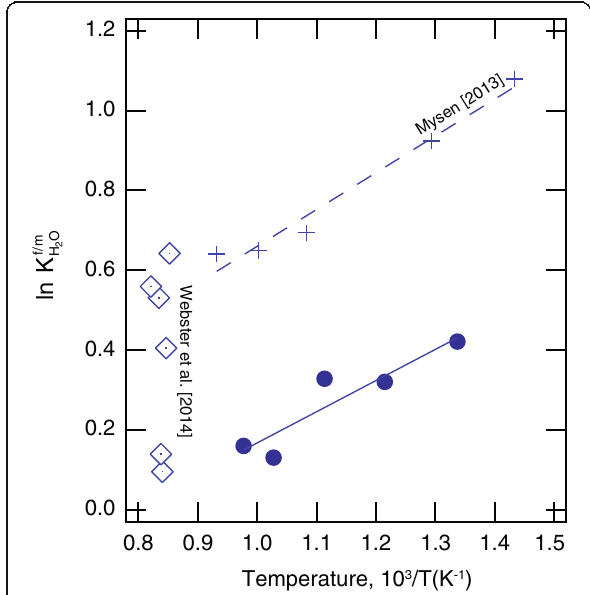
Fig. 13 Partition coefficient between fluid and melt of total H 2 O, K H2Of/m , as a function of temperature. The least squares straight line fit is, K H2Of/m = − 0.6±0.2+782±189/T, r 2 =0.85. Also shown are data from natural samples by Webster et al. (2014) and from experimental data in silicate – H 2 O from Mysen (2014). The least squares fit through the data of Mysen (2013) yields the expression, K H2Of/m = − 0.3±0.1+782±920/T, r 2